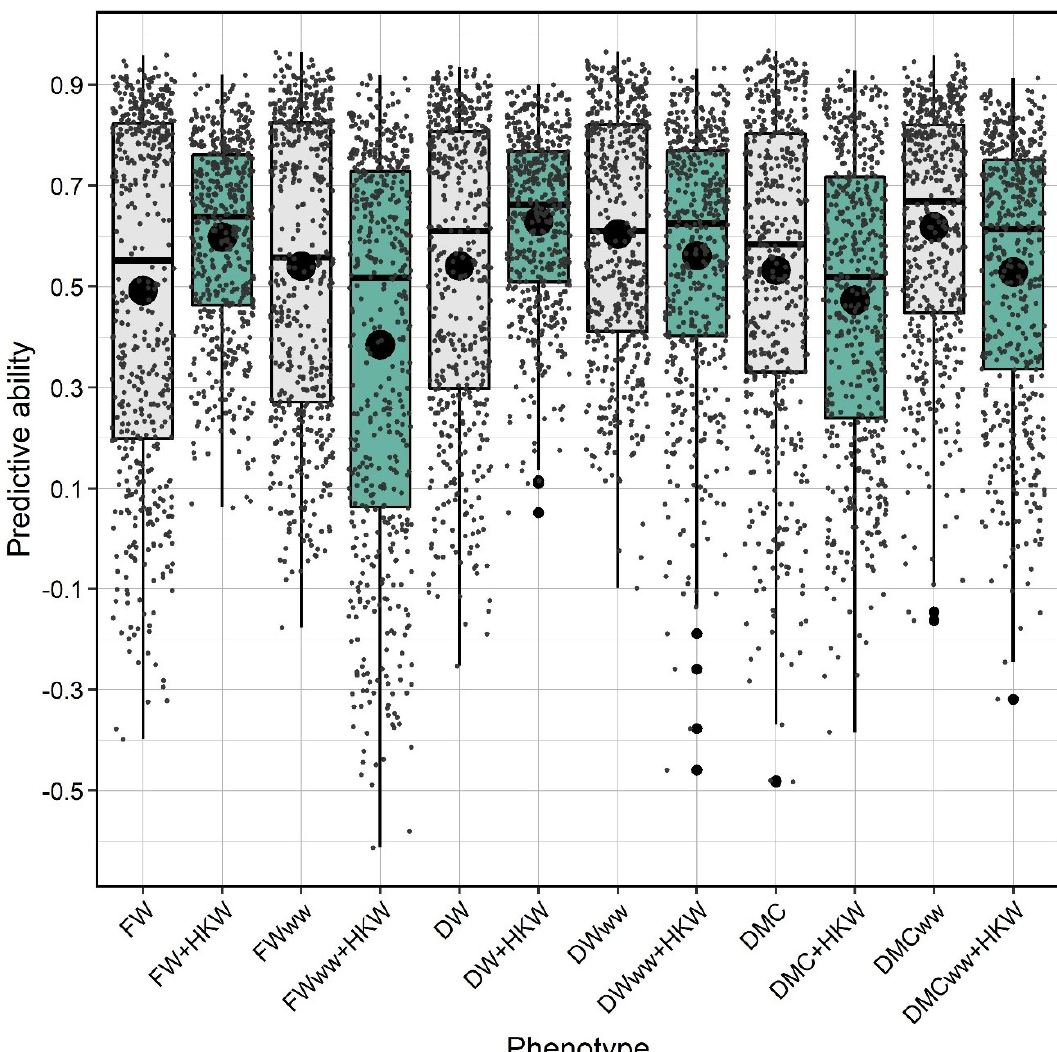
Figure 4. Predictive abilities of genomic prediction models with and without hundred kernel weight (HKW) as a linear covariate for fresh weight (FW), dry weight (DW), and dry matter content (DMC). Dark lines within the boxplots represent the median, and the dark dots represent means of 500 random folds in k-fold cross validation. Gray dots are the predictive abilities from each fold. Differences between mean predictive abilities for each trait with and without covariate are significantly different at α = 0.05.